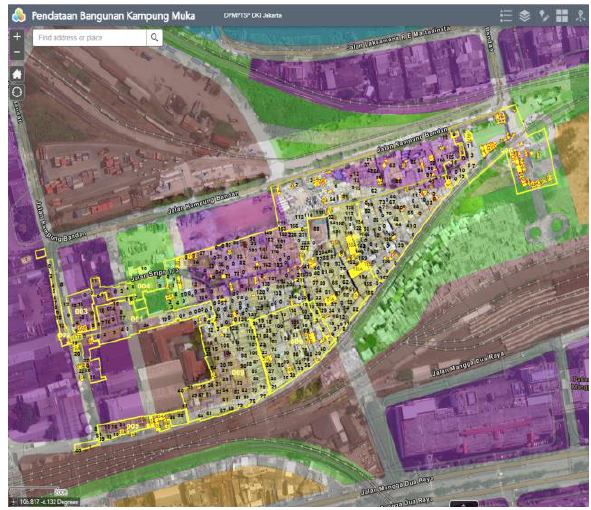
Figure 6 . Interface of Web-GIS Application